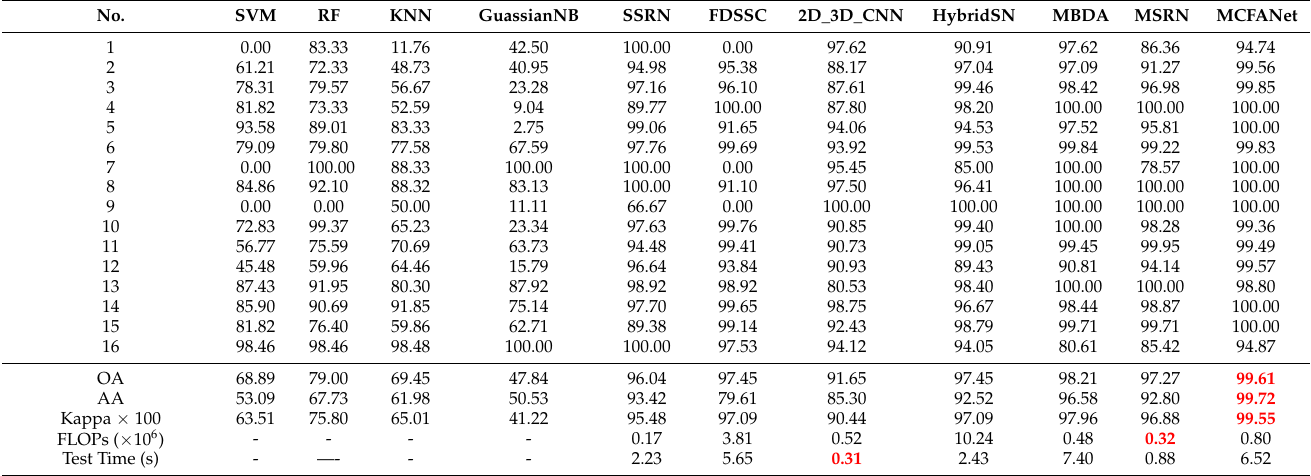
Table 5. The classification accuracies of comparison approaches on the IP dataset.